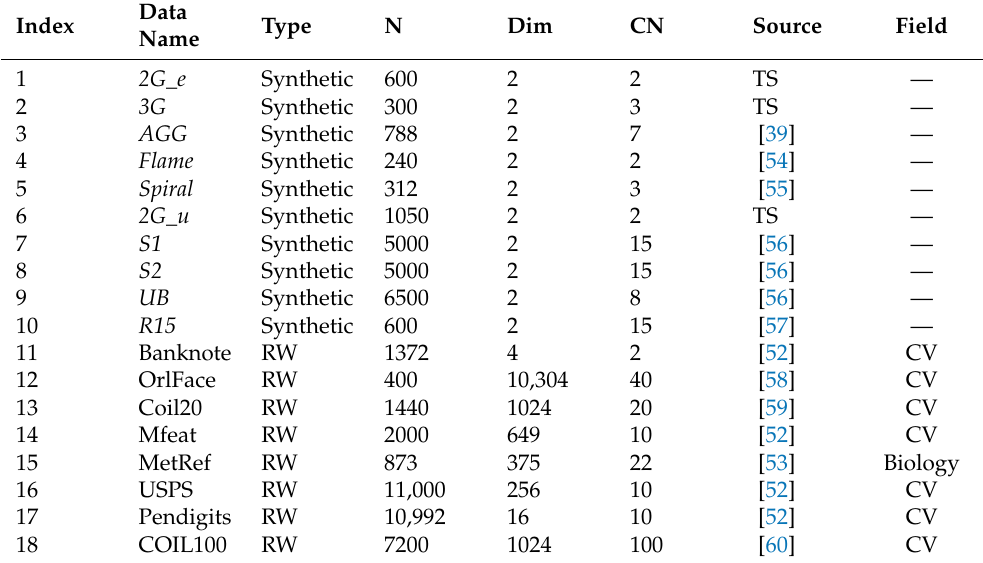
Table 3. Characteristics of the test datasets. N : number of samples; Dim: number of dimensions;